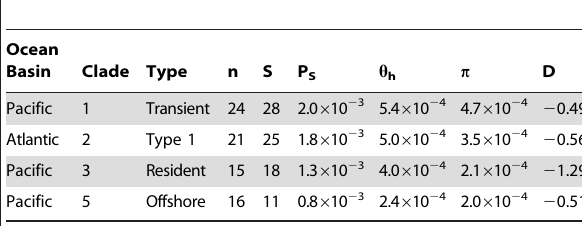
Table 1. Summary genetic diversity statistics for clades containing four or more complete mitogenome